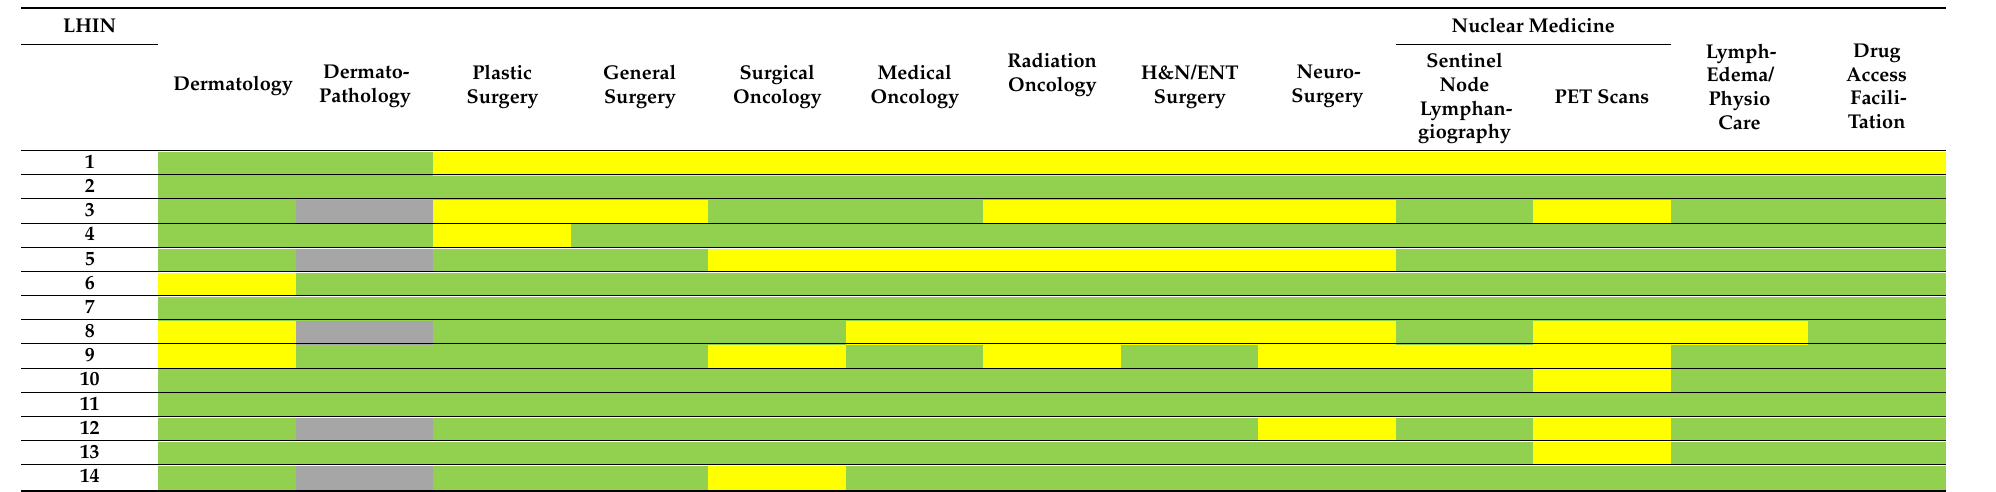
Table A3. Access to Specialist Service for Skin Cancer Care in Ontario by